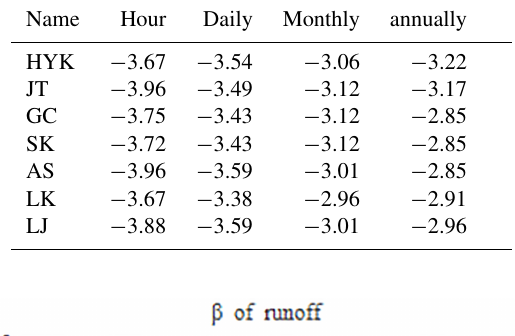
Table 1. Z c of runoff in different time scale.